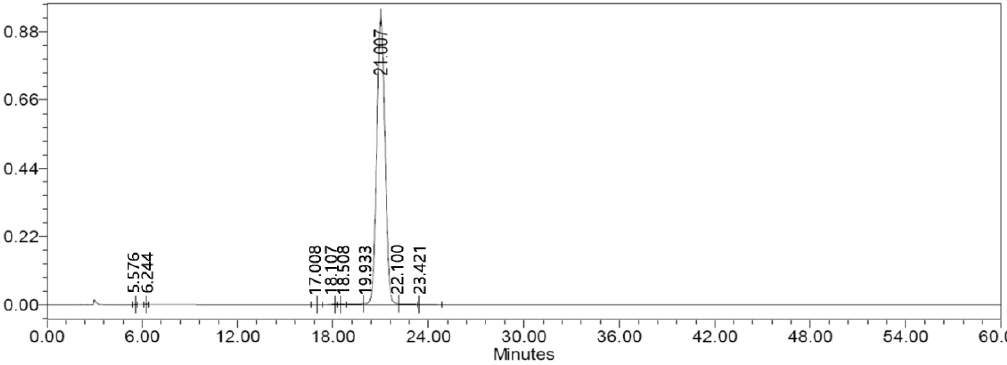
Figure 5. The purity of SAG detected by HPLC. SAG was analyzed by HPLC with UV detection at 204 nm. The analysis was performed with a C-18 column (4.6 mm × 250 mm) at 35 ◦ C. It was eluted (eluent A: acetonitrile; eluent B: 0.2% phosphate solution) at a flow rate of 1.0